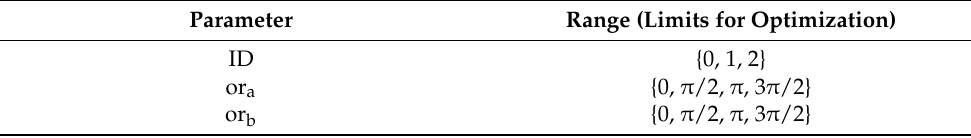
Table 2. Joint module parameters used for optimization.